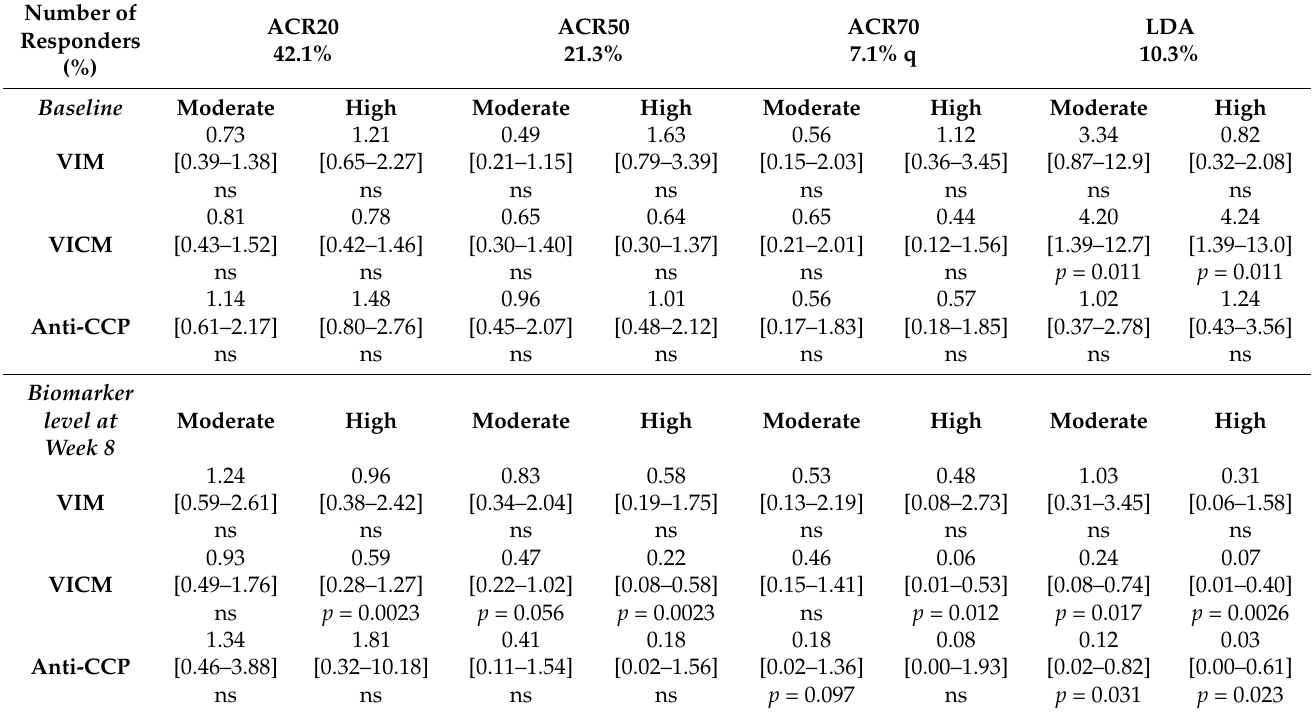
Table 3. Baseline prediction of response using the biomarkers including all patients. OR [95% CI] for being a responder from logistic regression comparing patients with the lowest levels of bi- omarker (first tertile) with the second and third tertiles at either baseline or at week 8. ORs were adjusted for baseline biomarker level (week 8 only), age, sex, BMI and disease duration. Ns, non- significant (p>0.05).